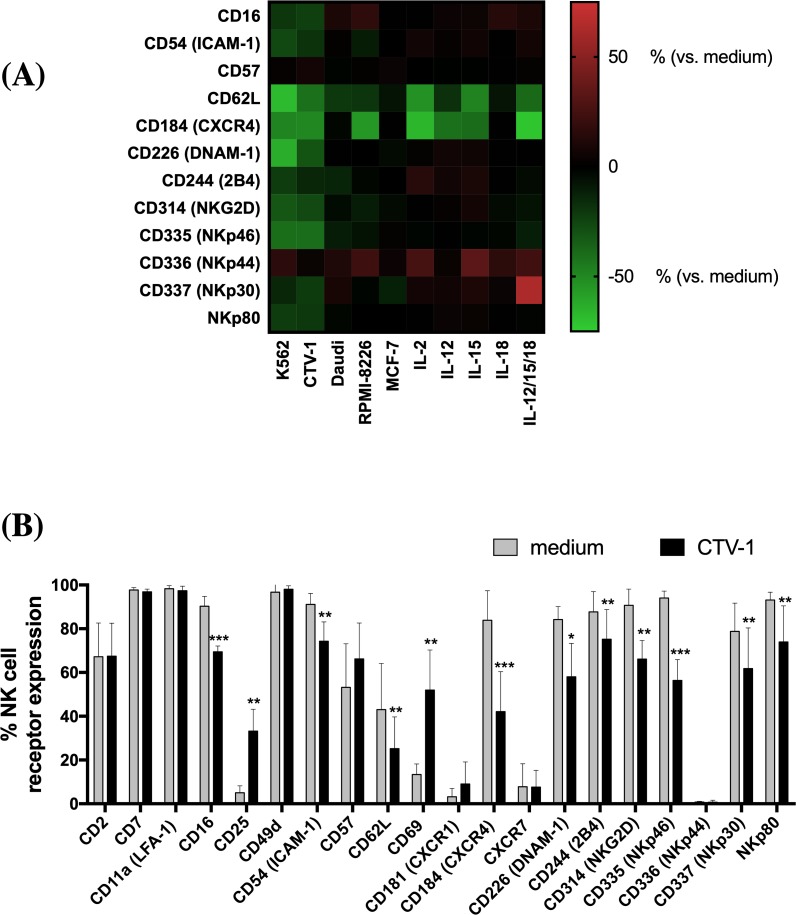
Loss of NK cell activation receptor expression following tumor-priming.(A) Freshly isolated NK cells were incubated in medium alone, with K562, CTV-1, Daudi, RPMI-8226, or MCF-7 cells or with IL-2/12/15/18 (individually or in combination) overnight at 37°C. Thereafter, cells were washed. NK cell activation receptor expression was analyzed using flow cytometry. The percentage change of NK cell expression was calculated for each receptor after stimulation and results are presented as the mean of 3–5 different donors. Red indicates an increase, and green indicates a decrease in receptor expression, according to the key on the right, relative to NK cells in medium alone. (B) Freshly isolated NK cells were incubated in medium alone or with CTV-1 cells overnight at 37°C. Cells were washed, the surface expression of 20 different NK cell activation receptors was analyzed. Bars represent the means ± SD of 5 different donors. The percentages of NK cell expression of different receptors after stimulation was compared with those in cells treated with medium alone using the paired t-test. Statistical significance is indicated as: *P <0.05; **P <0.01; ***P <0.001.